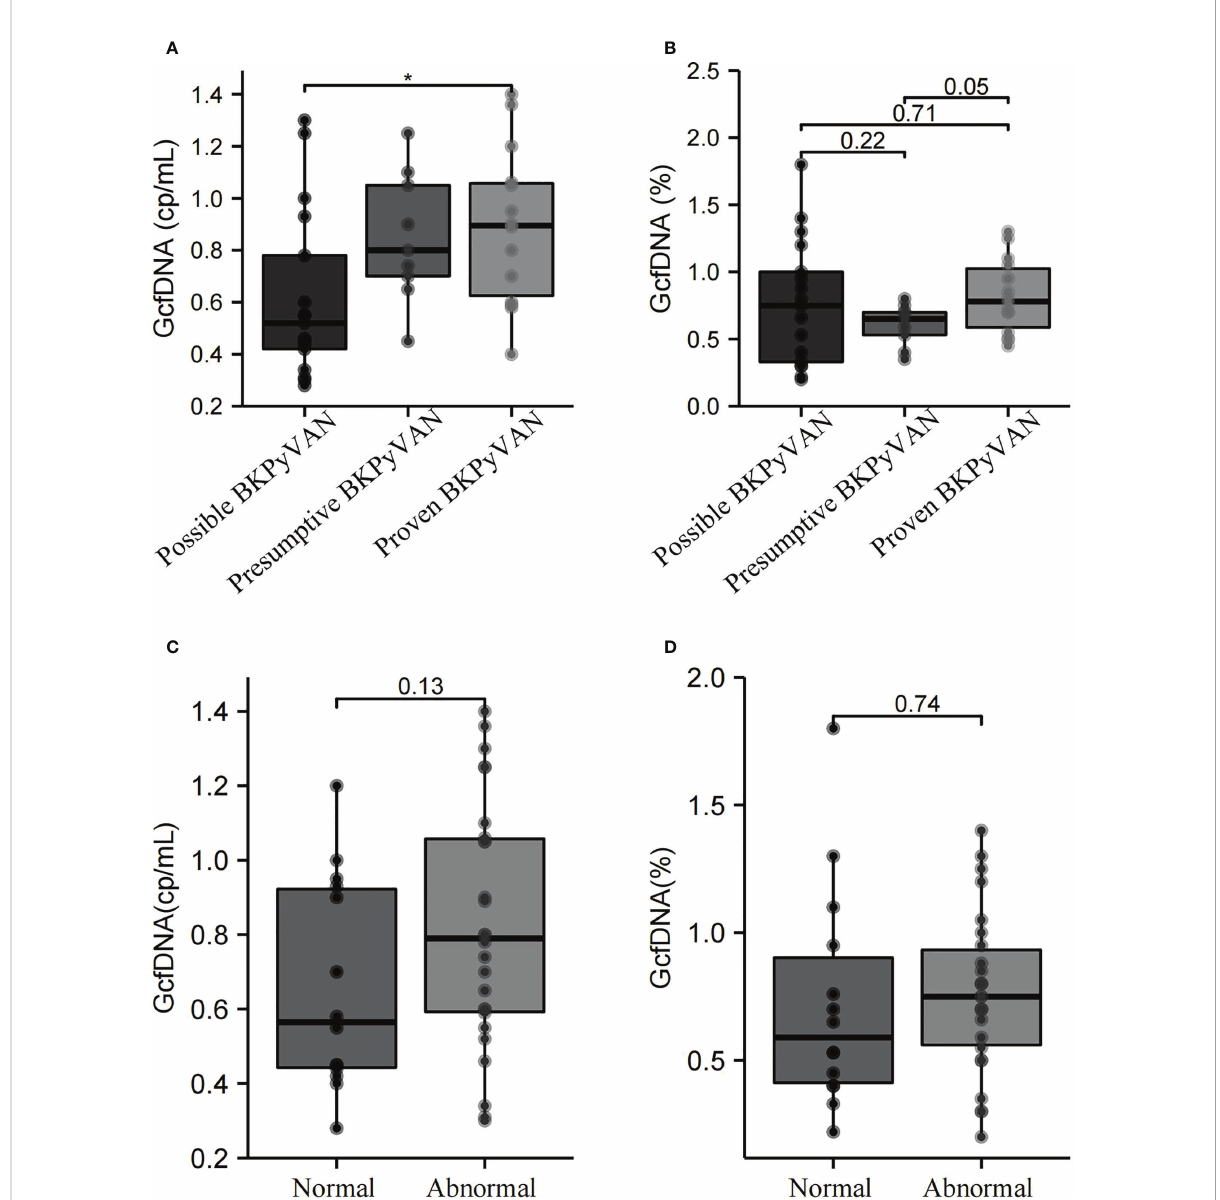
FIGURE 2 GcfDNA (cp/mL) and GcfDNA (%) in the possible BKPyVAN, presumptive BKPyVAN, and proven BKPyVAN groups were collected at biopsy time. (A) Boxplot with bold line represents the median GcfDNA (cp/mL) level in each subgroup; (B) Boxplot with bold line represents the median GcfDNA (%) level in each subgroup. GcfDNA (cp/mL) and GcfDNA (%) of between creatinine normal and abnormal groups. (C) Boxplot with bold line represents the median GcfDNA (cp/mL) level in normal creatinine group and abnormal creatinine group; (D) Boxplot with bold line represents the median GcfDNA (%) level in normal creatinine group and abnormal creatinine group. * P<